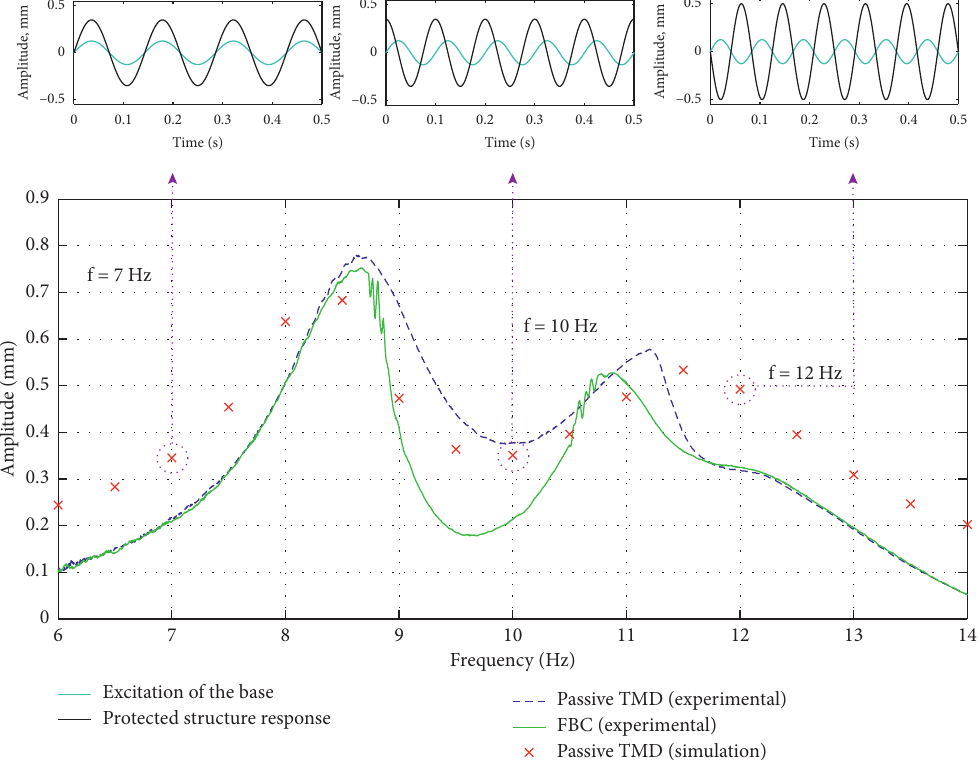
Figure 9: Frequency domain analysis of the protected